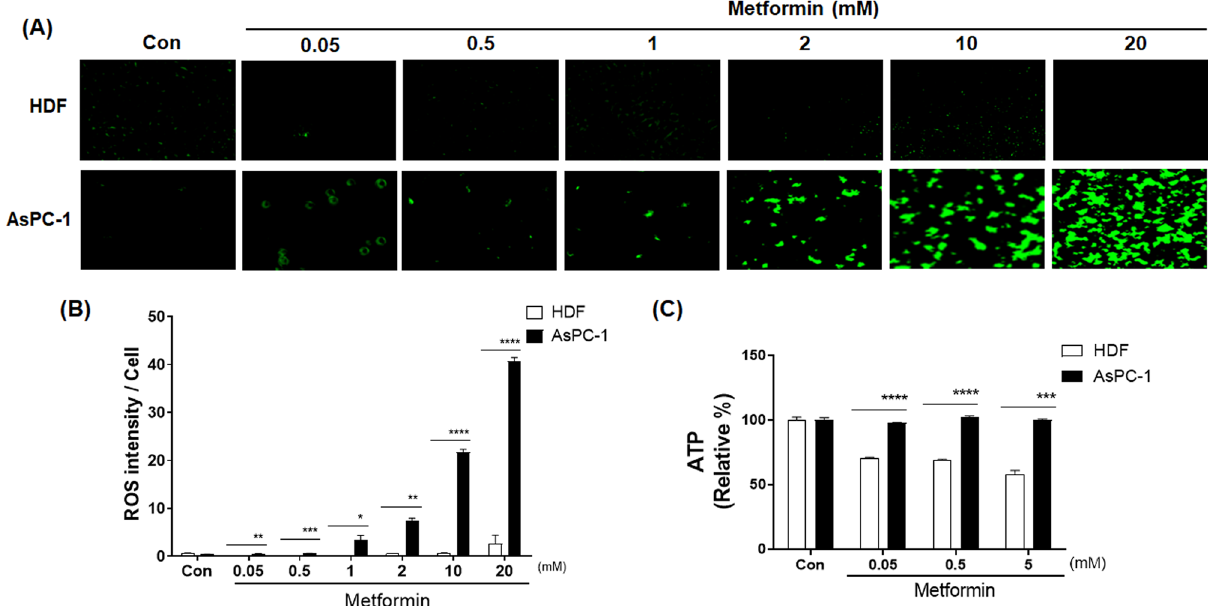
Figure 1. Effects of metformin on cellular ROS and ATP levels in human AsPC-1 and HDF cells. ( A ) Cellular ROS production was detected by CellROX Green staining in AsPC-1 and HDF cells after incubation with metformin (0, 0.05, 0.5, 1, 2, 10 and 20 mM) for 48 h. ( B ) Corresponding quantitative analysis of ROS levels. ( C ) Cellular ATP production was measured in ASPC-1 and HDF cells after incubation with metformin (0, 0.05, 0.5, and 5 mM) for 48 h. Three different measurements were performed for each sample. Statistical significance is indicated as * p < 0.05, ** p < 0.01, *** p < 0.001, and **** p < 0.0001 compared with HDF group.